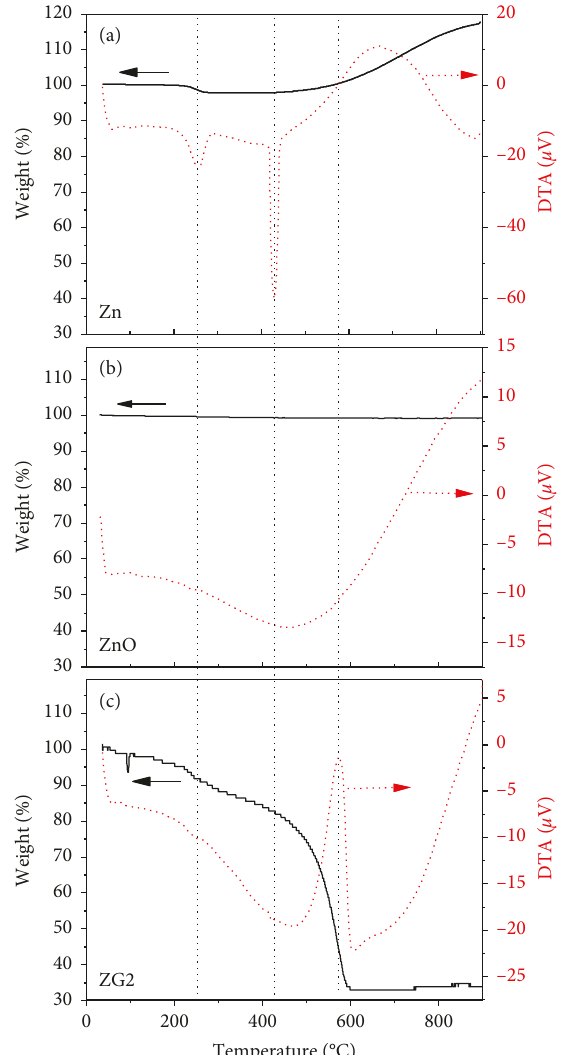
Figure 6: Comparative thermal gravimetry and differential thermal calorimetric (TG-DTA) measurements of samples Zn, ZnO, and